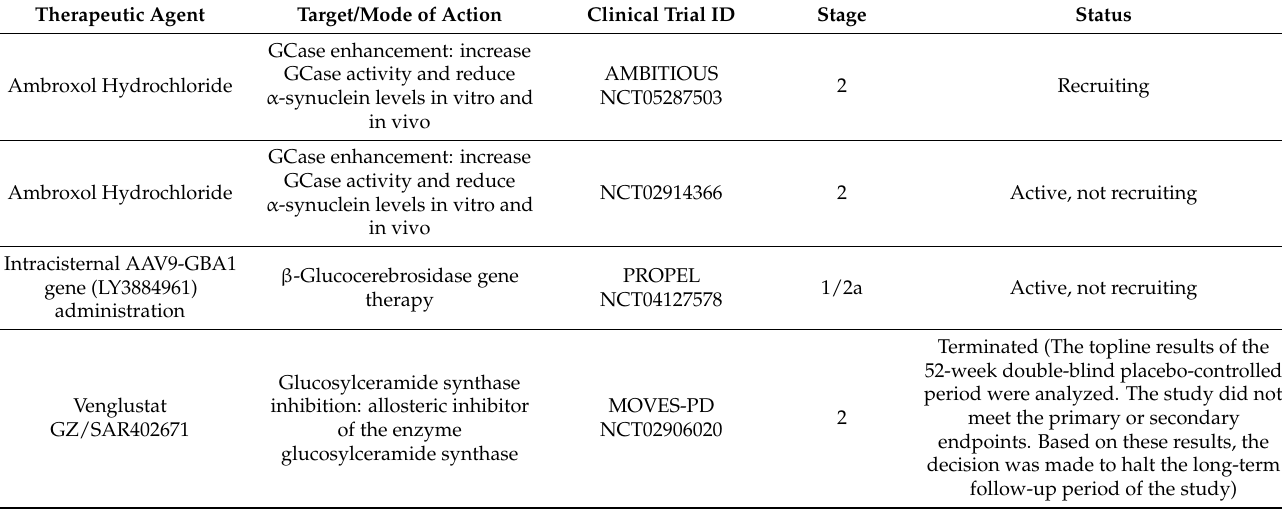
Table 2. Clinical trials of therapeutic interventions in GBA-PD